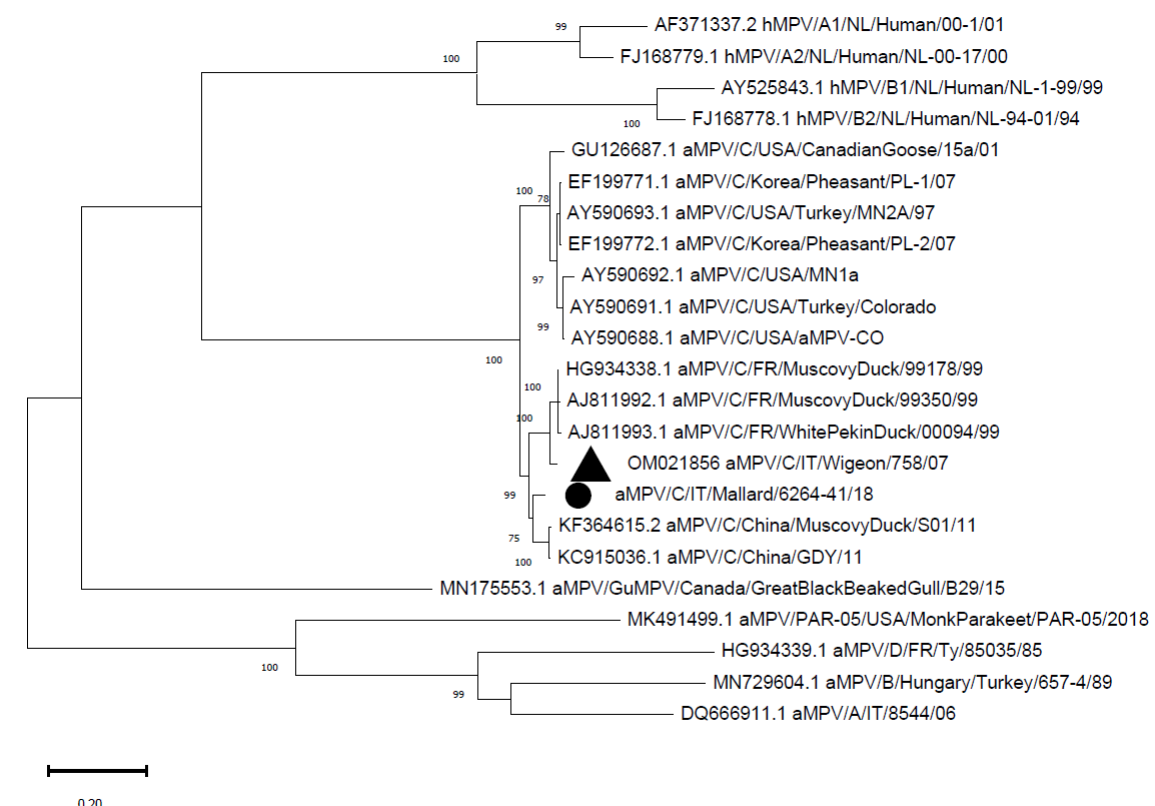
Figure 2. Phylogenetic tree reconstructed using the G gene of aMPV strains from Supplementary Table S2. The Italian mallard strain is marked with a black circle, whereas the previously detected Italian strain is marked with a black triangle. The tree was reconstructed using the Maximum Likelihood method and Hasegawa-Kishino-Yano model with discrete Gamma distribution (G) and a proportion of invariable sites (I). Bootstrap support (>70%) is shown next to the branches. This analysis involved 23 nucleotide sequences. All of the positions with less than 95% site coverage were eliminated. The final dataset was composed of 502 positions.